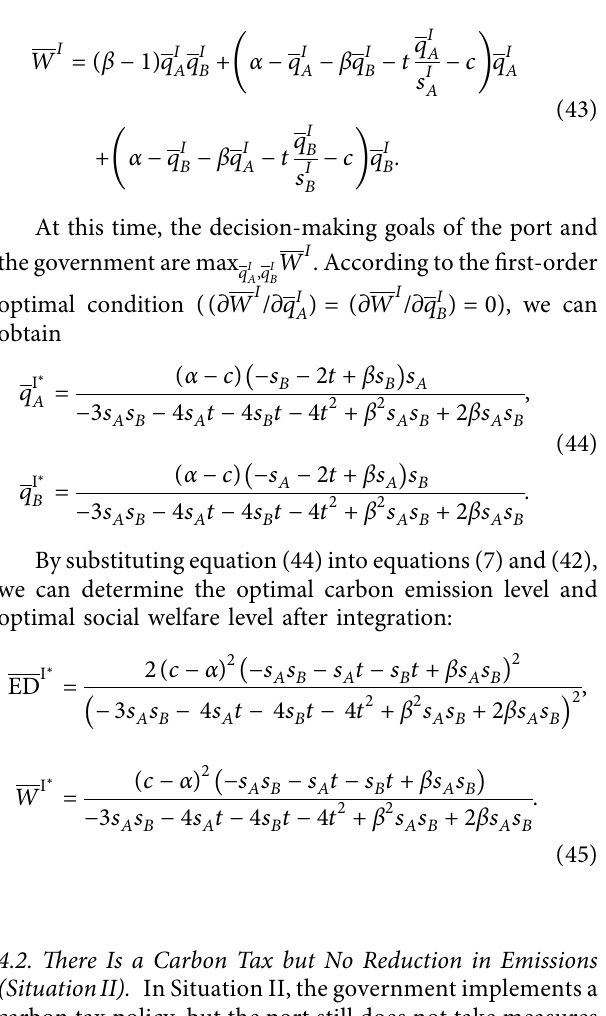
� 6 . 5, s � 5 . 8). (a) β � 0 . 2. (b) β � 0 . 4. (c) β � 0 . 6. (d) β � 0 . A B